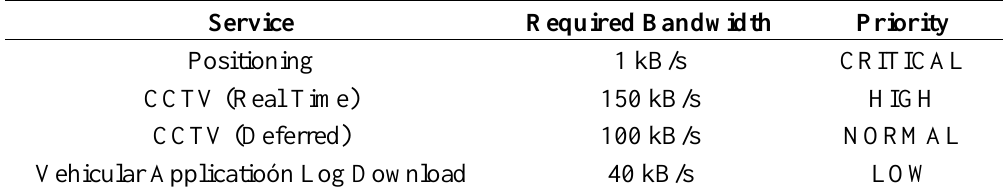
Table 1. Set of test applications.